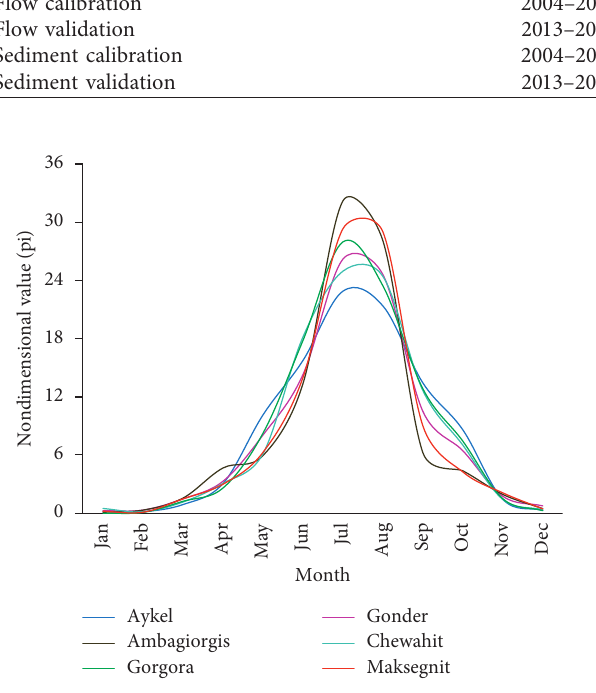
Figure 9: Homogeneity test plot of selected stations.